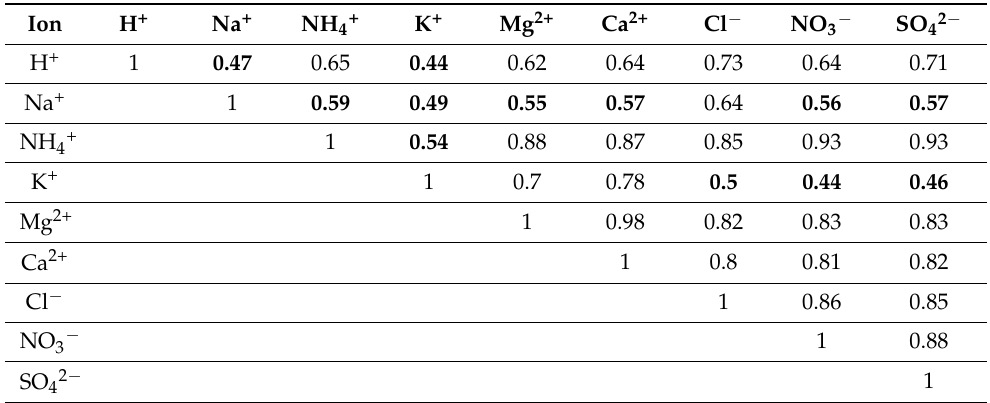
Table 3. Correlation matrix of ionic for high ion concentrations (>2.0 µ g/m 3 ) in the atmospheric aerosol of the Bolshiye Koty research station in